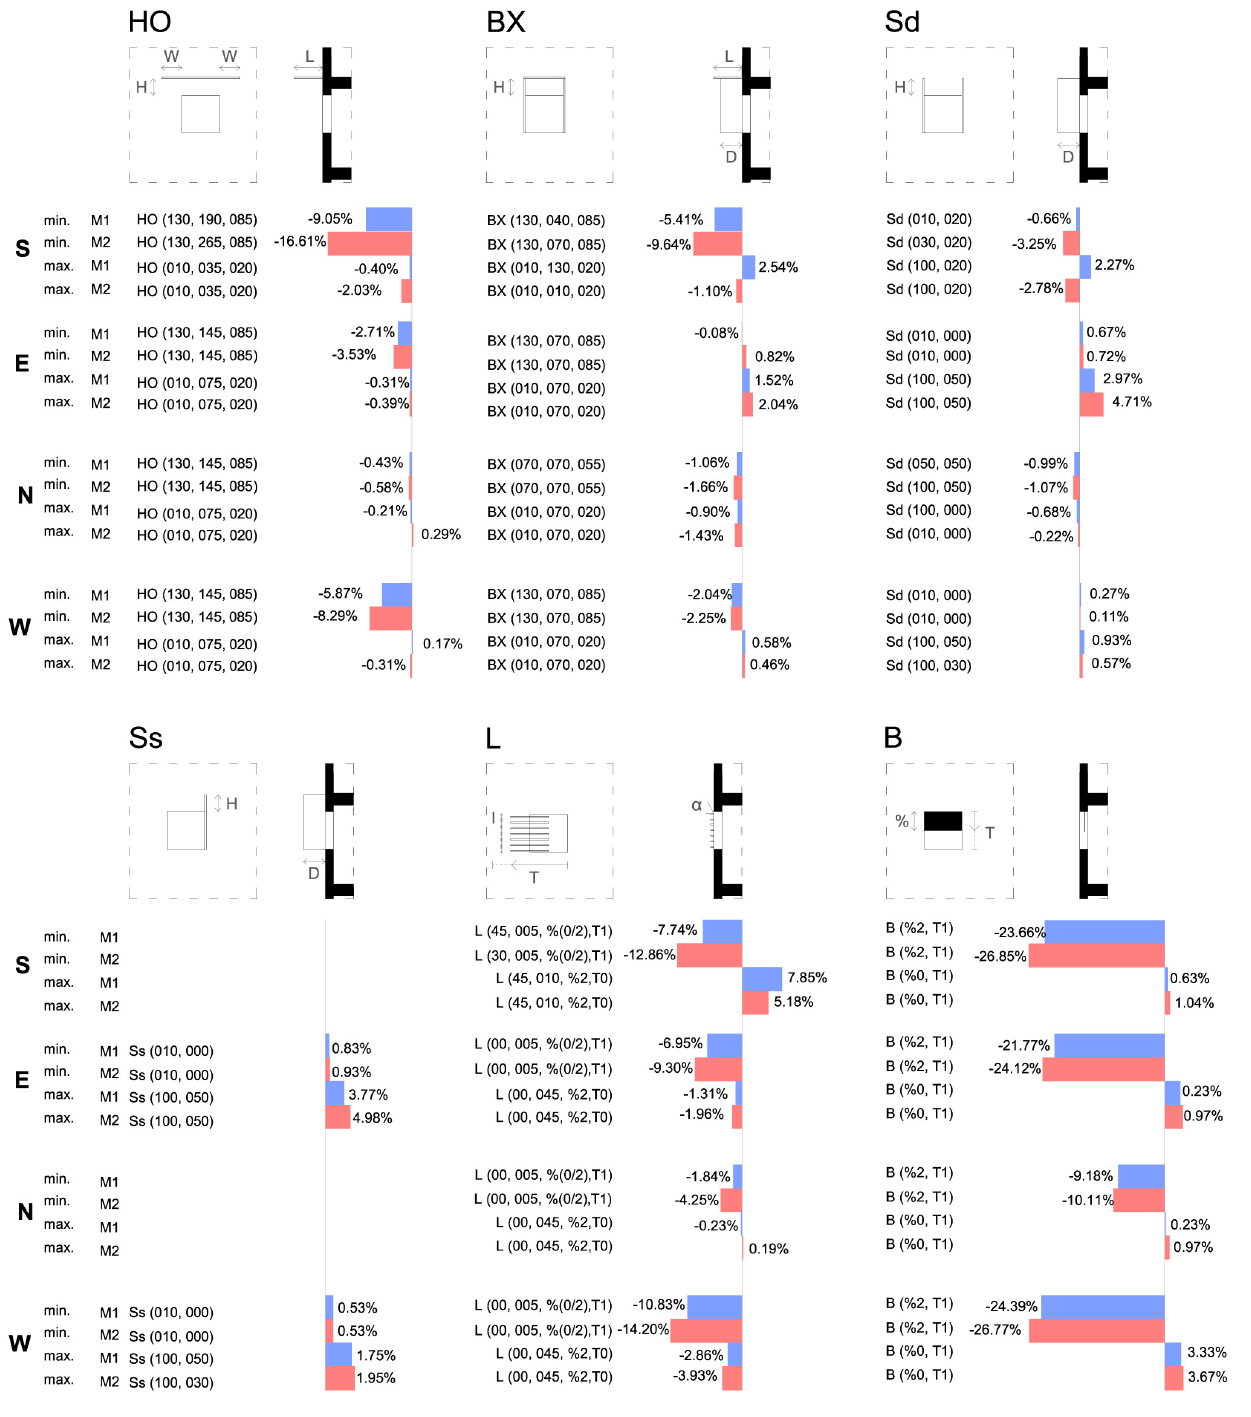
Figure 12. Maximum and minimum annual demand for each